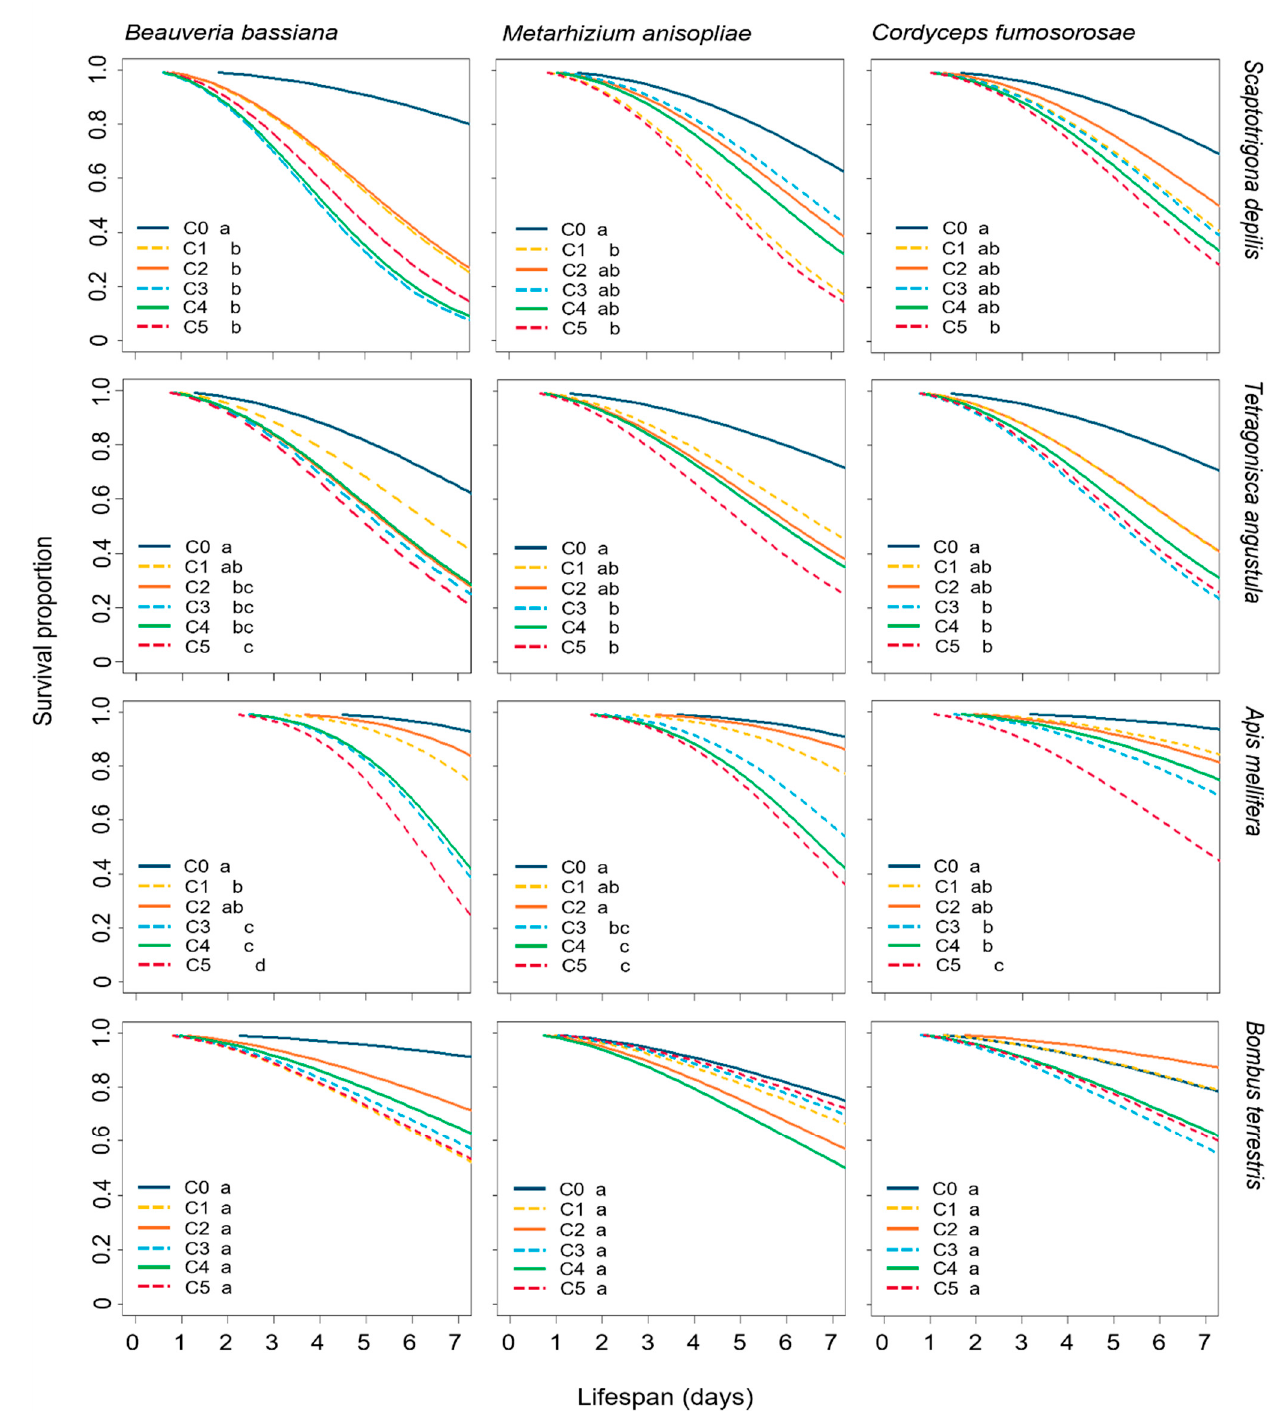
Figure 1. Survival proportion of workers ( Scaptotrigona depilis ( n = 150), Tetragonisca angustula ( n = 240), Apis mellifera ( n = 300) and Bombus terrestris ( n = 150)) to topical application of three entomopathogenic fungi, Beauveria bassiana , Metarhizium anisopliae and Cordyceps fumosorosea . Concentrations: control (C0), 5 × 10 5 conidia mL − 1 (C1), 1 × 10 6 conidia mL − 1 (C2), 5 × 10 6 conidia mL − 1 (C3), 1 × 10 7 conidia mL − 1 (C4), 5 × 10 7 conidia/mL − 1 (C5). Concentrations with different letters are significantly different ( p < 0.05).